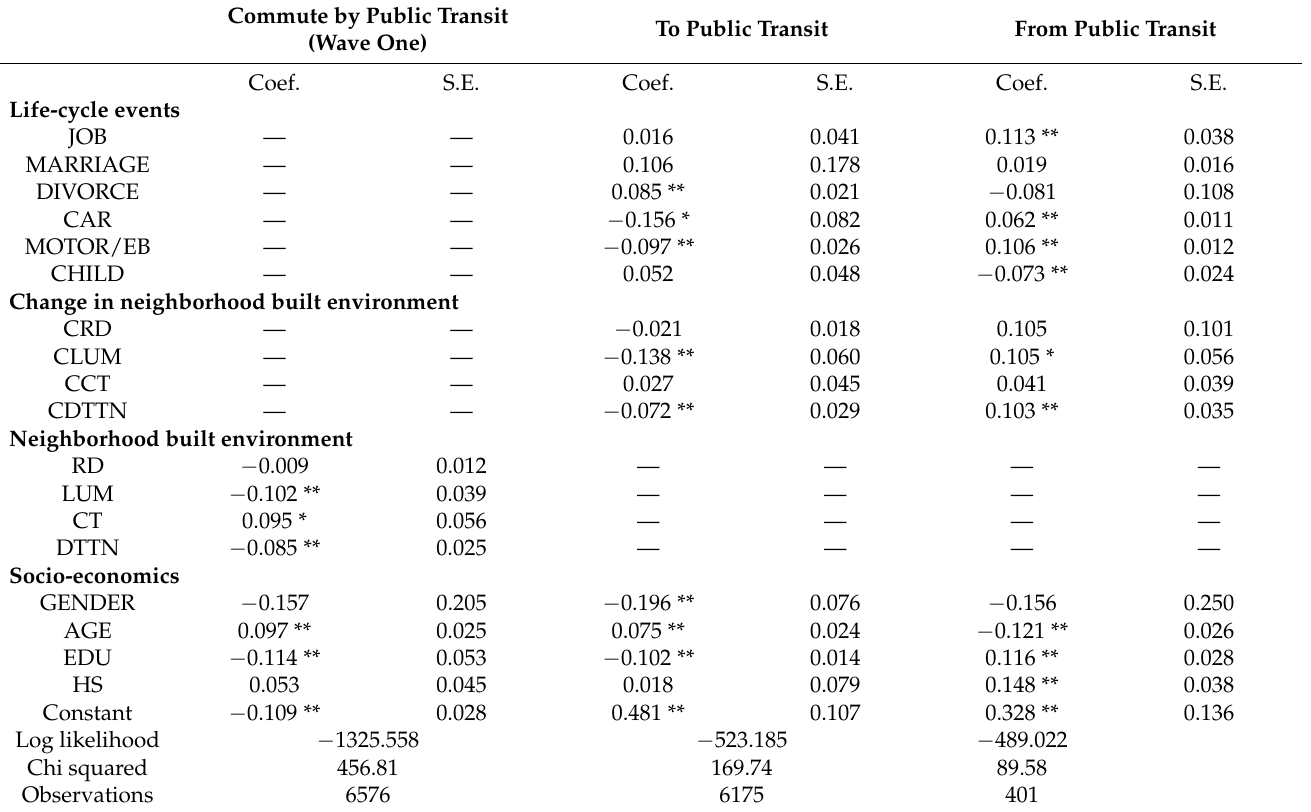
Table 6. Logistic models of public transit commuting and switches to and from this